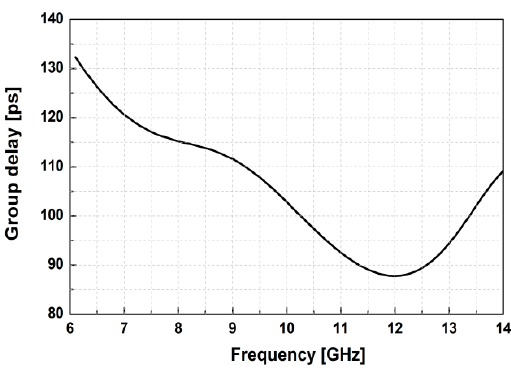
Figure 16. The group delay of the BDGA at frequencies from 6–14 GHz.